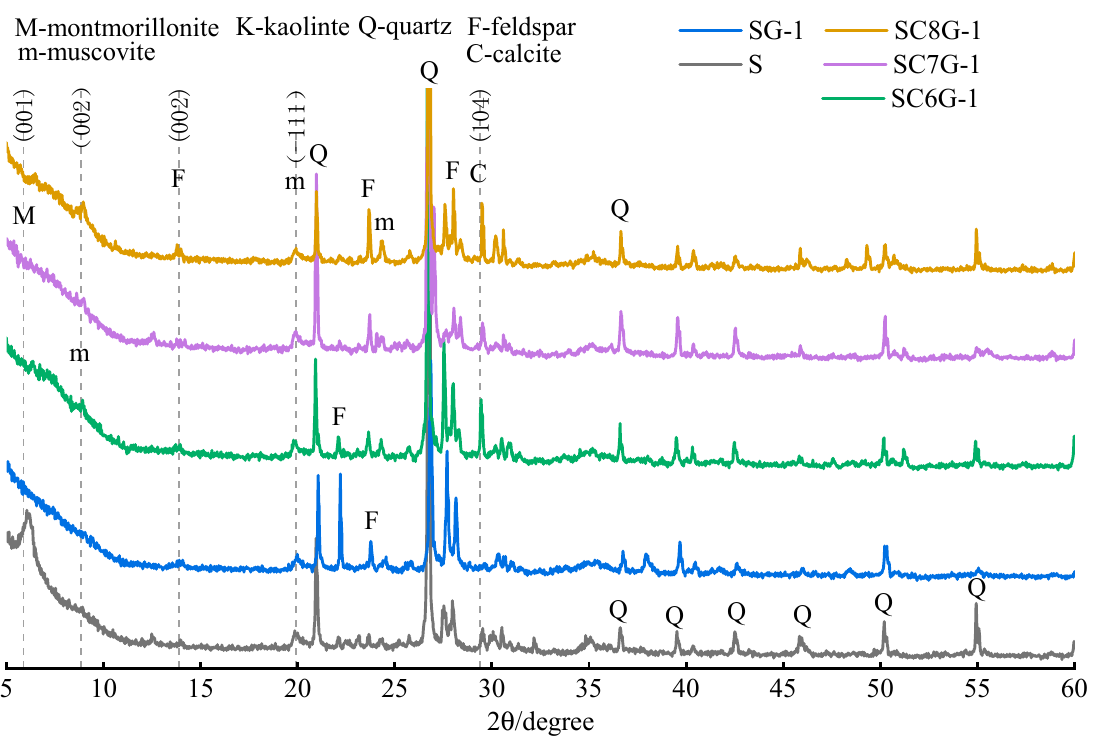
Figure 8. XRD of the residues after leaching. (SC*G: the thermally and mechanochemically activated WPS was immersed in a solution of 1.0 M NaOH for 28 days, and the value of * was the temperature of thermal activation; S: WPS sample immersed in distilled water for 28 days).